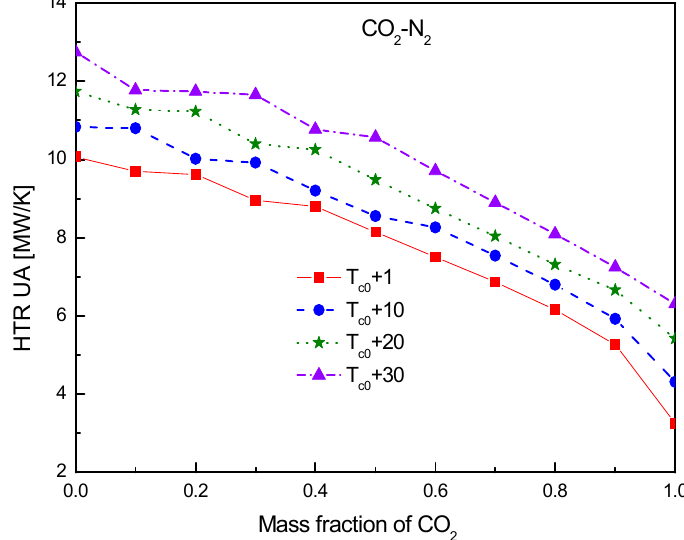
ff erent compressor inlet